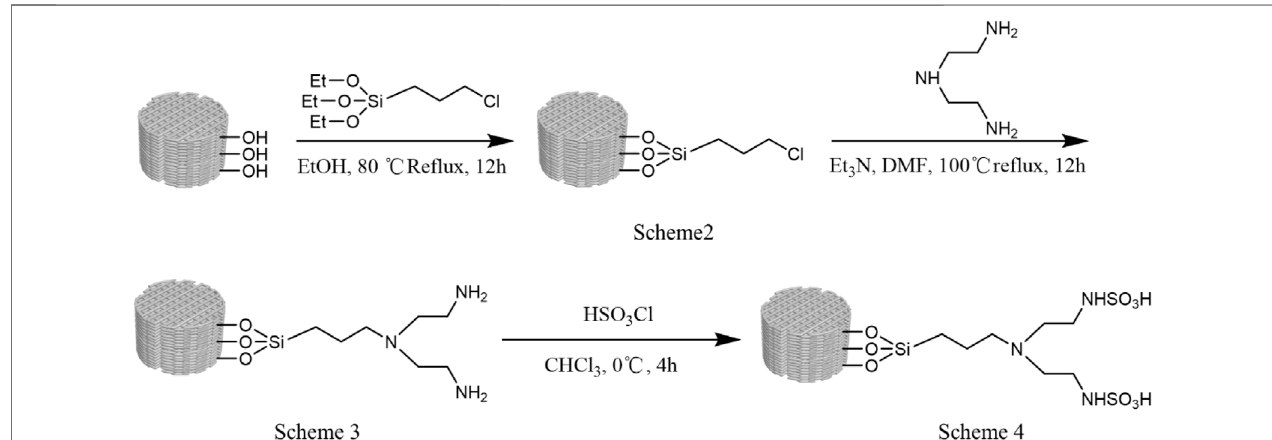
FIGURE 1 | Schematic of the 3D SiO 2 -NH-SO 3 H synthesis.